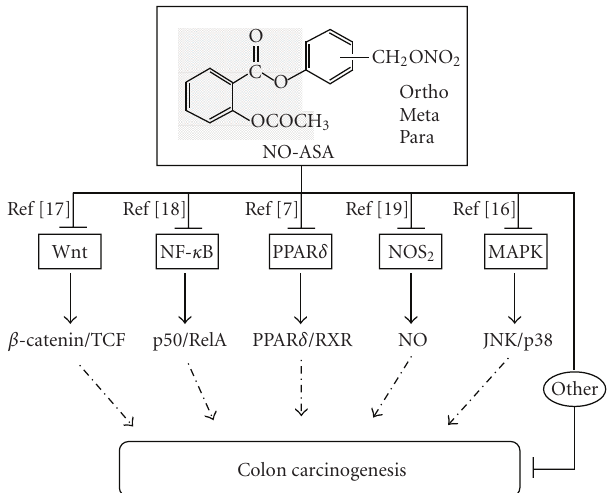
Figure 1: E ff ect of NO-ASA on PPAR δ and other signaling pathways. NO-ASA consists of a traditional ASA molecule (shaded), the spacer, and –ONO 2 , which releases NO, with the molecule being considered responsible for much of its pharmacological properties. There are three positional isomers of NO-ASA ( ortho , meta , and para ), depending on the position of –ONO 2 in the benzene ring with respect to the ester bond linking the ASA and spacer moieties. NO-ASA a ff ects several cell signaling pathways, all relevant to carcinogenesis. The modulation of these often cross-talking pathways culminates in a net inhibitory e ff ect on cell growth, one of the crucial determinants of the fate of a tumor. It is likely that such mechanistic pleiotropism by NO-ASA is central to its e ffi cacy against